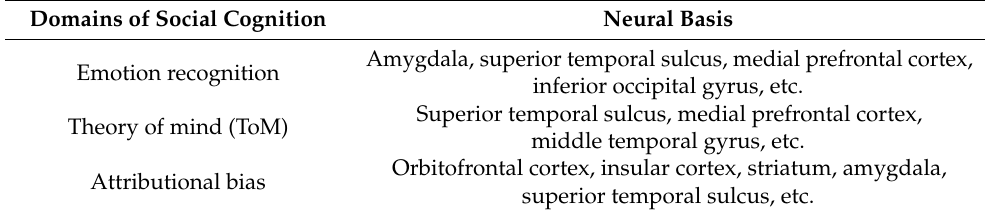
Table 1. Neural basis of social cognition